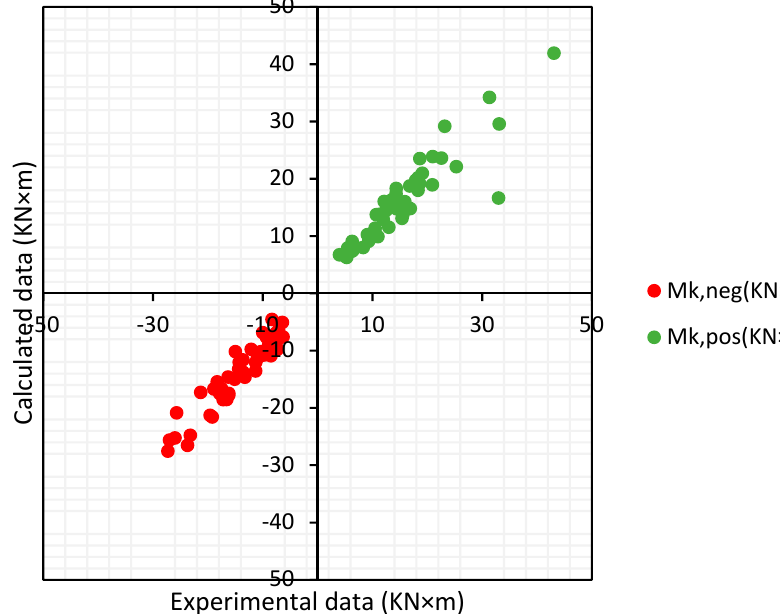
Figure 6. Comparison between experimental data and hand-calculated data. Table 2. Comparison of models’ prediction